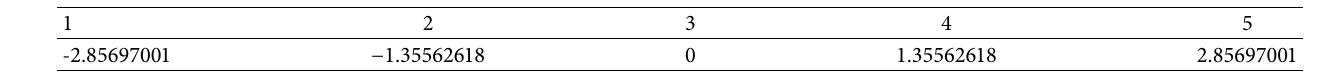
Table 3: Estimation points in the standard normal space.